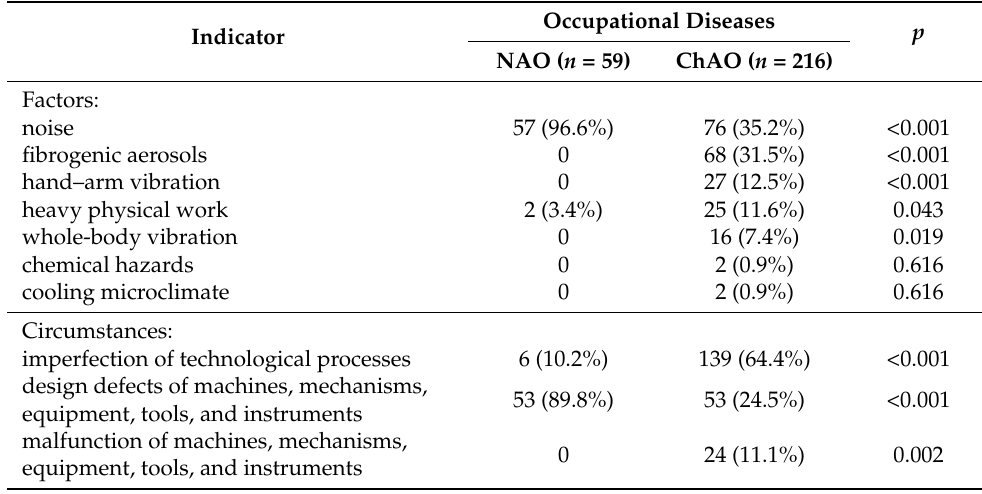
Table 4. Factors and circumstances associated with occupational disease development (cases and %).